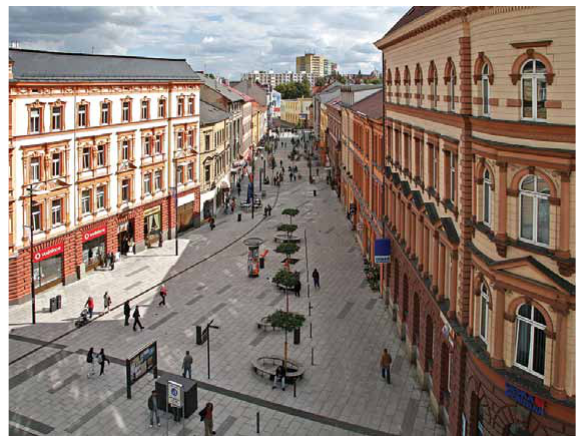
photofig. 7. a 69: Pedestrian street, Cheb, 2010. j. Moravcová